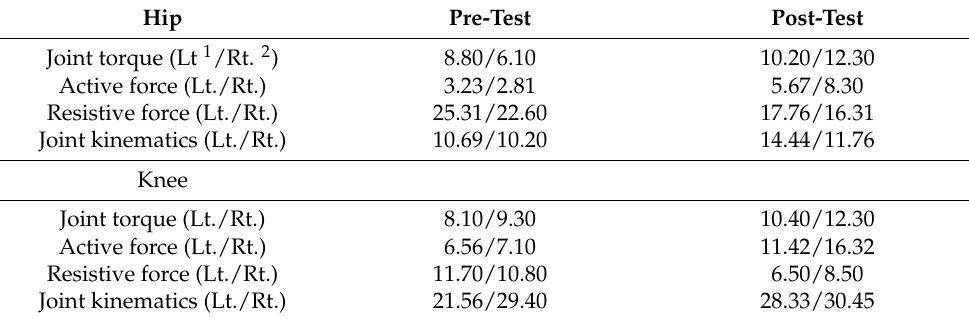
Table 3. Biomechanics